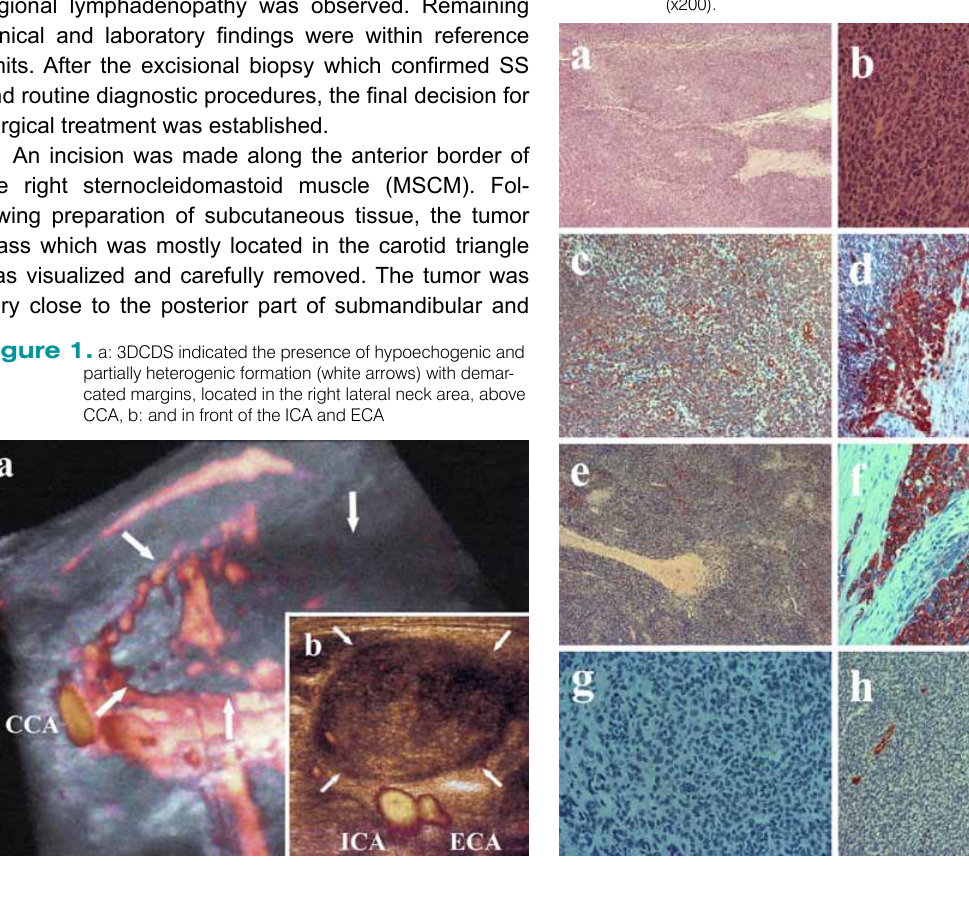
Figure 2. Histological features of SS: a,b: tumor was micro- scopically formed by solid areas of polymorph oval, ovoid and rarely spindle cells, light or scanty eosinophilic cytoplasm, irregular nuclei with numerous mitotic figures (over 30/10HPF) (HE staining technique, x100, x400), c: tumor cells were diffusely stained with vimentin, (x200), d: partially positive for EMA, (x400), e: CKAE1/AE3, (x100), f: bcl-2 (x400), g: negative for CD99, (x400), h: and CD34,